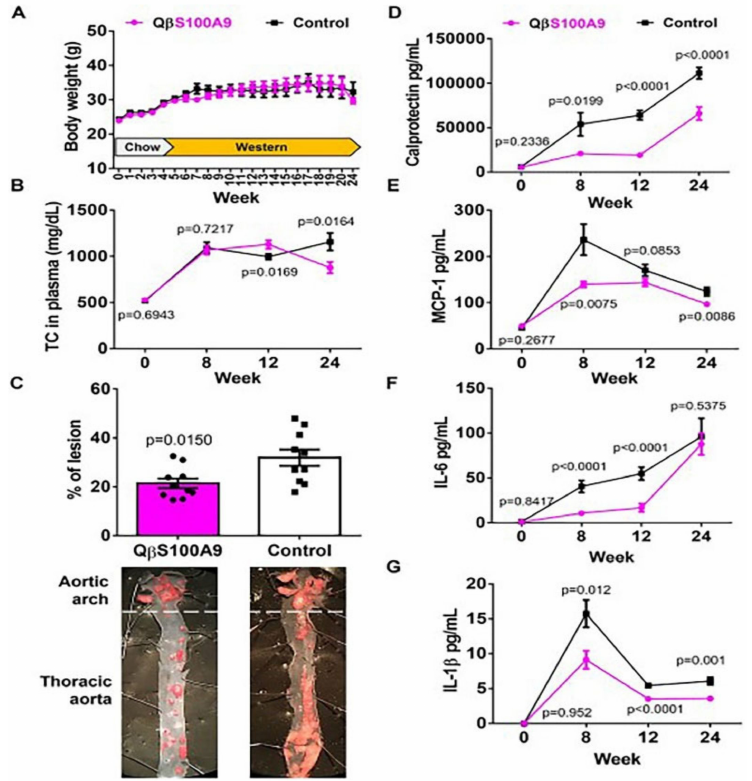
Figure 11. Effect of Q β S100A9 vaccine implantation on atherosclerosis in mice on a high-fat diet, ( A ) Body weight (grams), ( B ) The concentration of total cholesterol in plasma., ( C ) The presence of atherosclerotic plaques shown as the percentage of lesion determined by oil red O staining., ( D ) Plasma concentrations of calprotectin, ( E ) Plasma concentrations of MCP-1, ( F ) Plasma concentra- tions of IL-6, ( G ) Plasma concentrations of IL-1 β . Data are means ± SEM ( n = 10), unpaired two-tailed t -test, 95% confidence value, p < 0.05 was considered the threshold for statistical significance versus control group [99]. Copyright 2022,